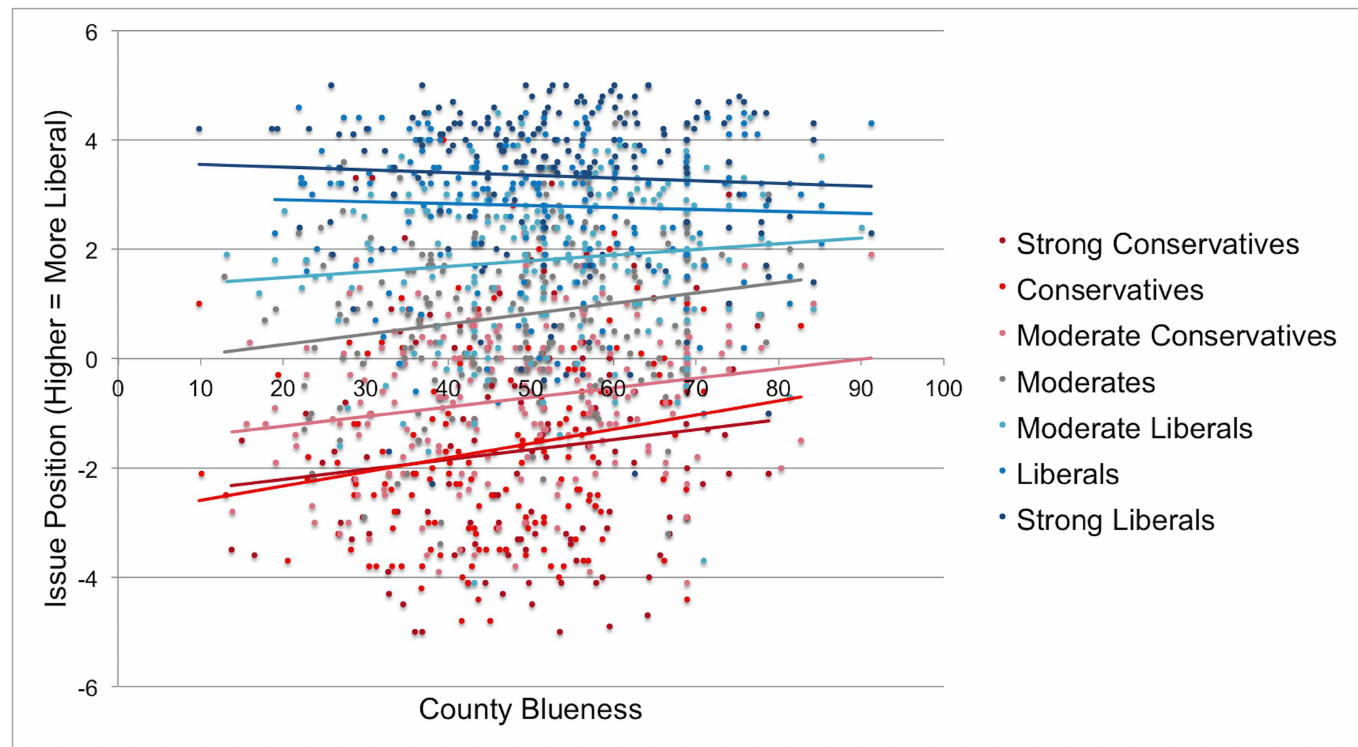
Fig 2. County blueness indicates percentage of participant’s county voting democrat in the 2012 presidential election. Lines are linear trendlines calculatedseparatelyfor each level of politicalidentity. If politicalideologyhad the same meaningregardlessof locationthe trendlineswouldbe flat.